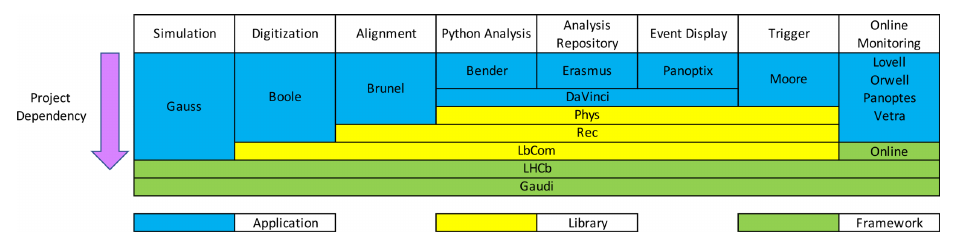
Figure 1. LHCb physics software